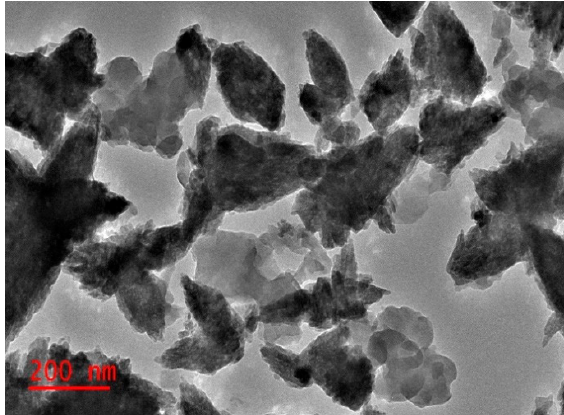
Figure 3. Transmission Electron Microscopy (TEM) image of synthesized ZnO-NPs-PL.